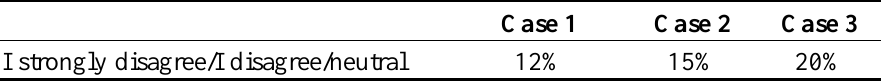
Table 3. Reflective practice is not part of everyday work.